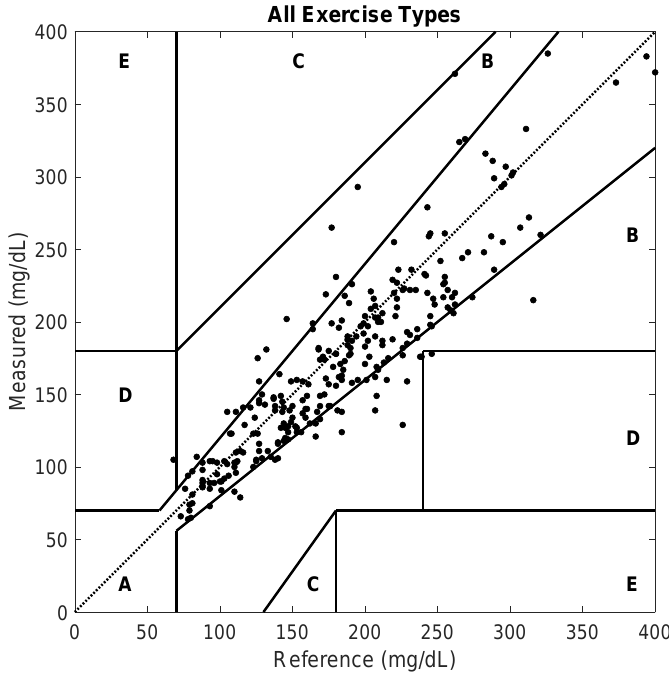
Figure 3. Clarke error grid analysis showing paired CGM and capillary (reference) glucose for all exercise types